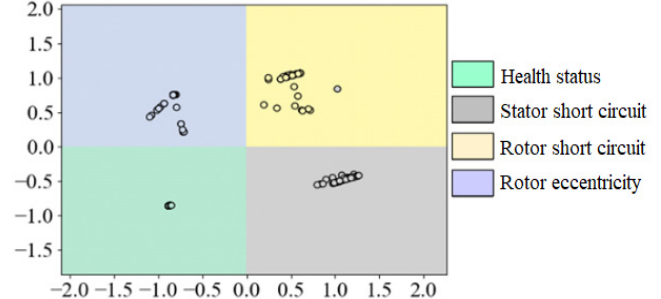
Figure 8. Classification result with the fuzzy process.